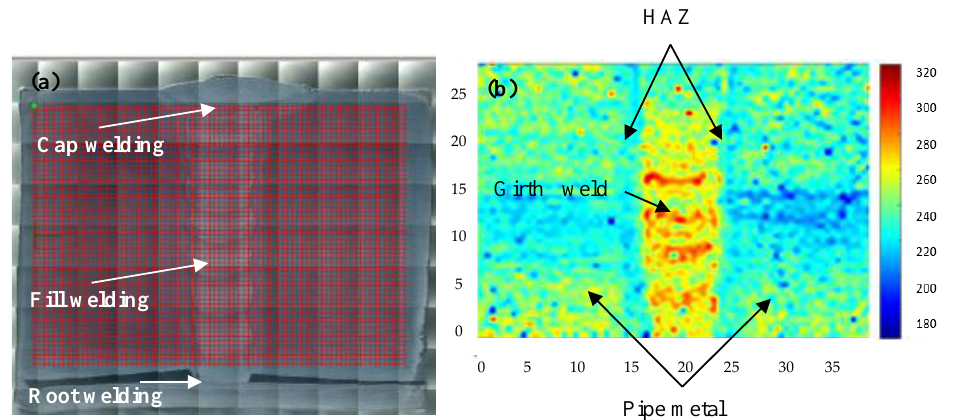
Figure 5. The hardness cloud map of girth welding joint for the high-strain marine pipe. ( a ) The zone of hardness cloud map for the girth welding joint; ( b ) The cloud map for the specimen. The properties of HAZ are similar to that of the pipe metal and difficult to obtain (HAZ is too small to test). The relationship between the tensile property and hardness is linear [22]. Thus, the stress-strain curves of HAZ can be obtained using the test results for the pipe metal according to the results of the hardness cloud map.